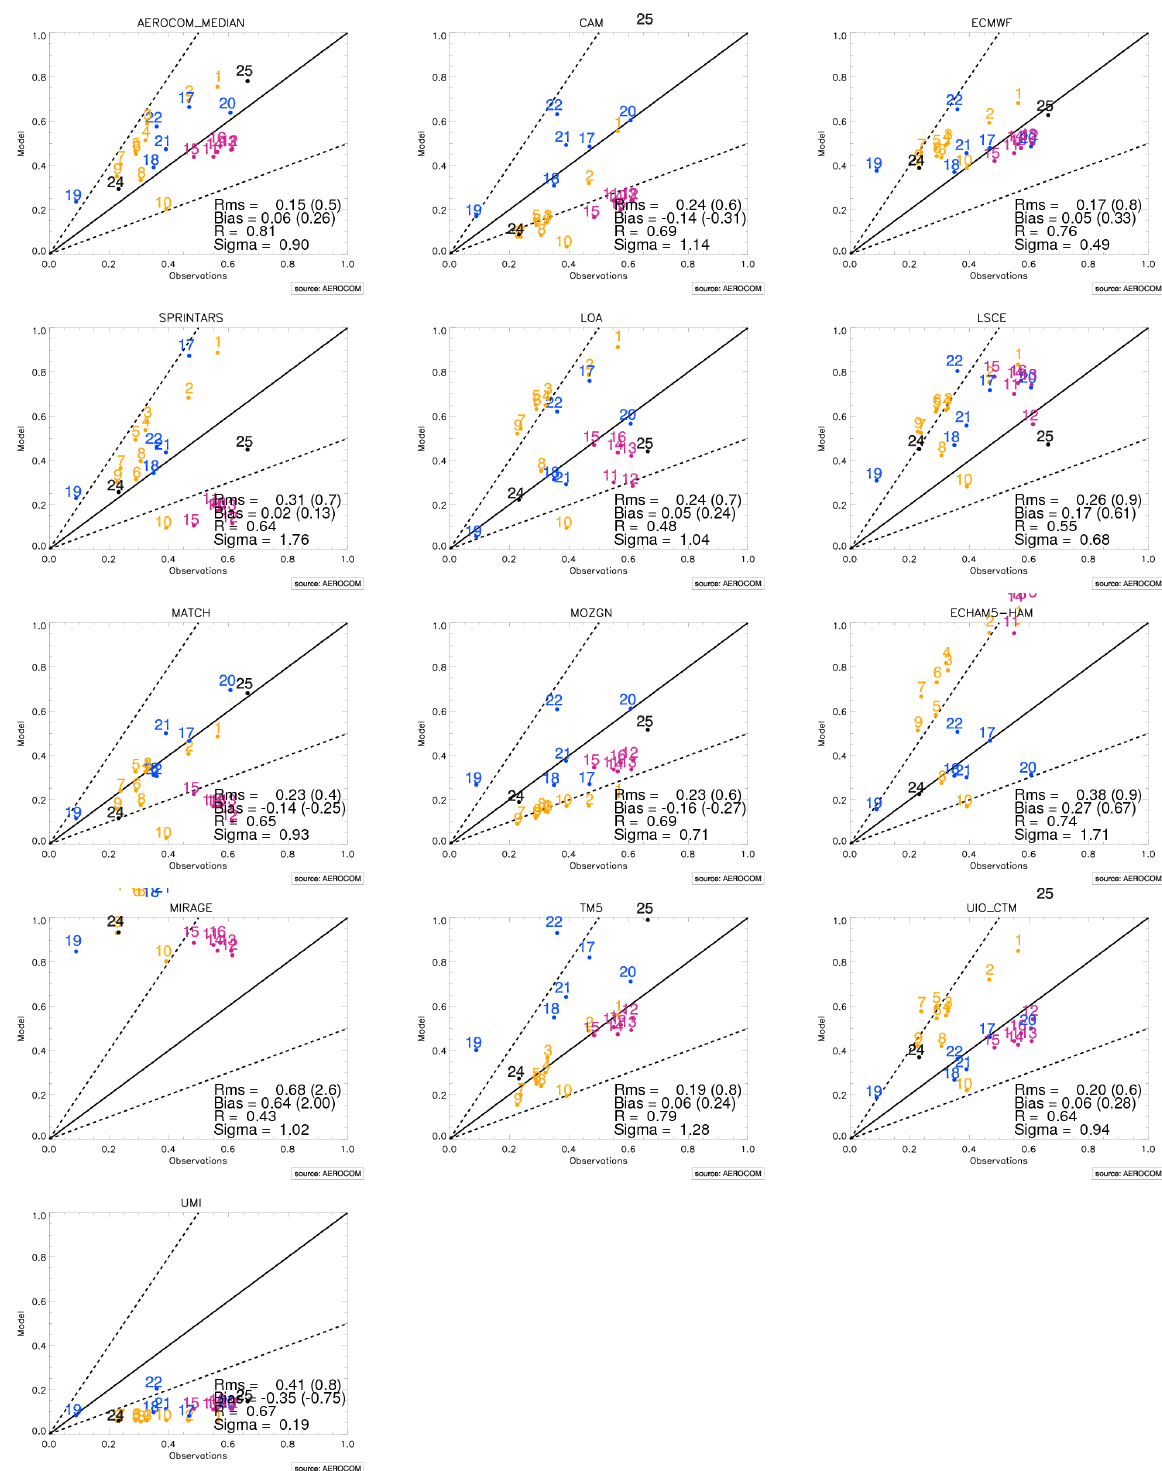
Fig. 12. Same as Fig. 9 but for Angstr¨om